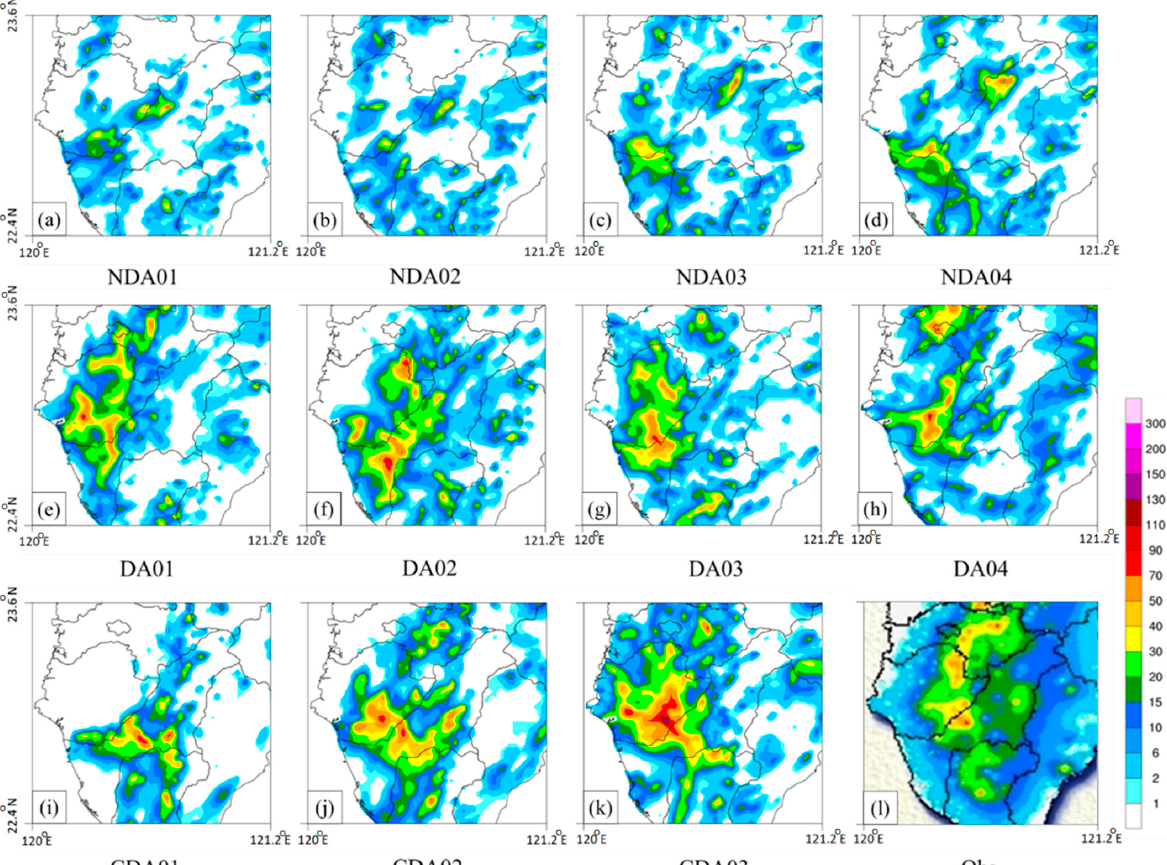
Figure 8. The simulated accumulated precipitation (mm) during 0500-1100 UTC (1300-1900 LST) on